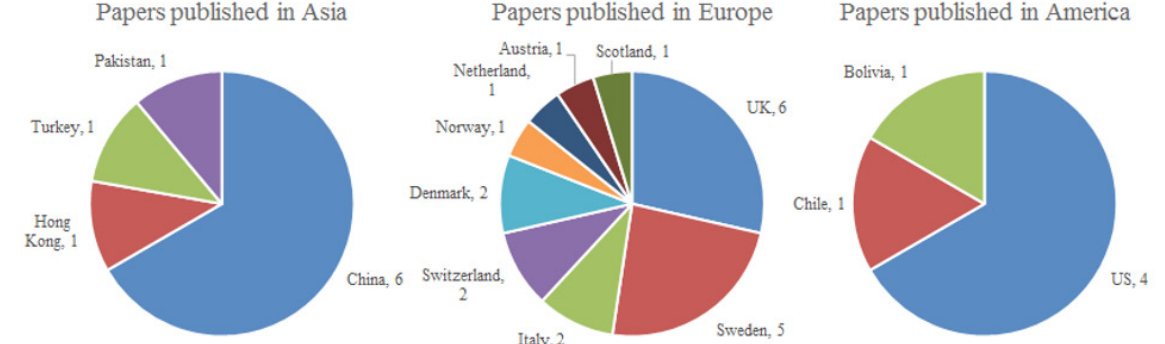
Figure 4: Articles published on perceptions of and preferences for greenspaces based on the location of their case These findings show that there are fewer studies in Africa, America (other than the US) and Asia (other than China) (Fig. 3).